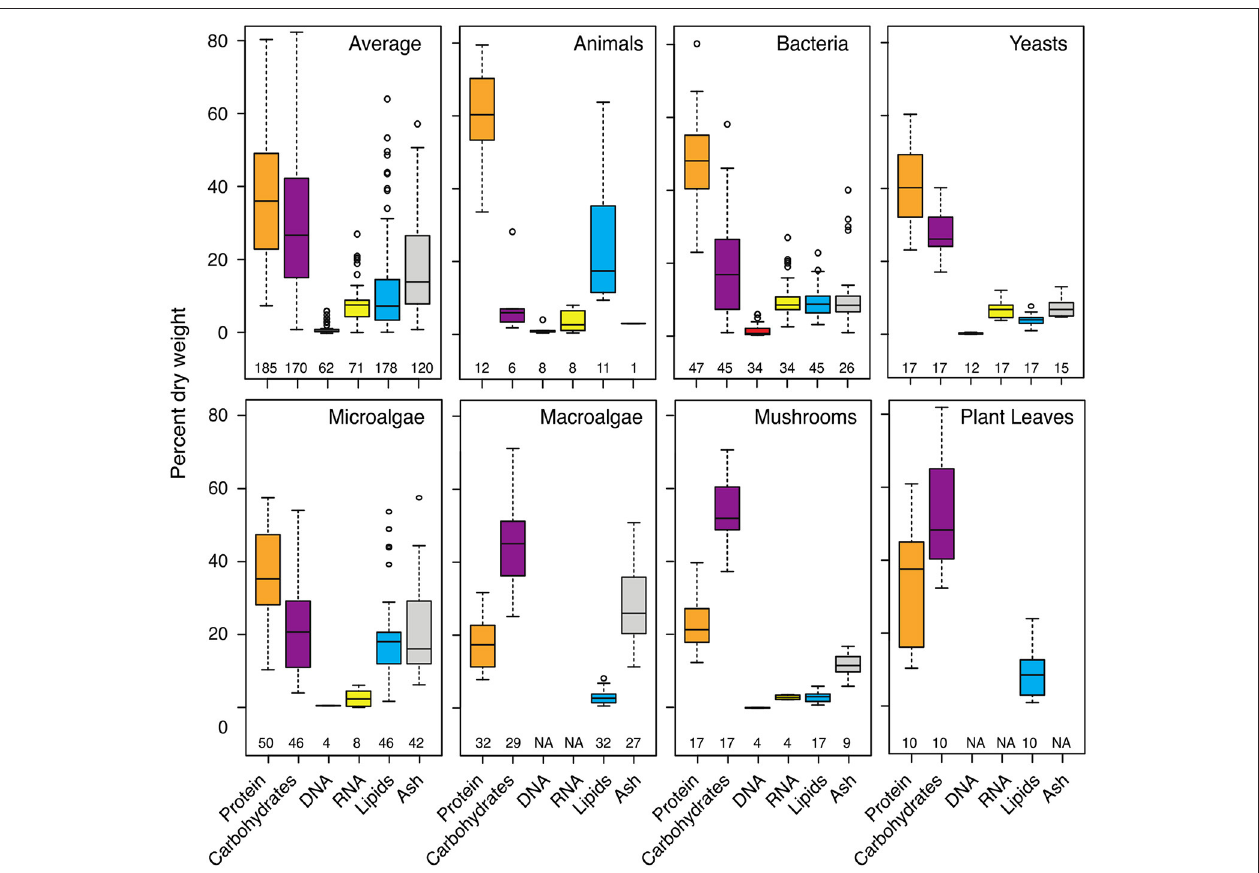
FIGURE 1 | Abundance of major classes of cellular macromolecules in different organisms. The macromolecular composition of cells and organisms can vary greatly between lineages, between species, and even between different body parts or developmental stages of the same organism. Proteins and carbohydrates (mainly polysaccharides) constitute most of the biomass of a generic cell averaged across all included organisms. The abundance and importance of proteins or polysaccharides or other macromolecules as a source of energy, carbon, and nutrition, however, greatly differs between ecosystems depending on its community. The values are taken from studies listed in Supplementary Table 1 . The number of included samples is given below each boxplot. “Average” percentages were calculated from all shown organisms and are subject to change with additional